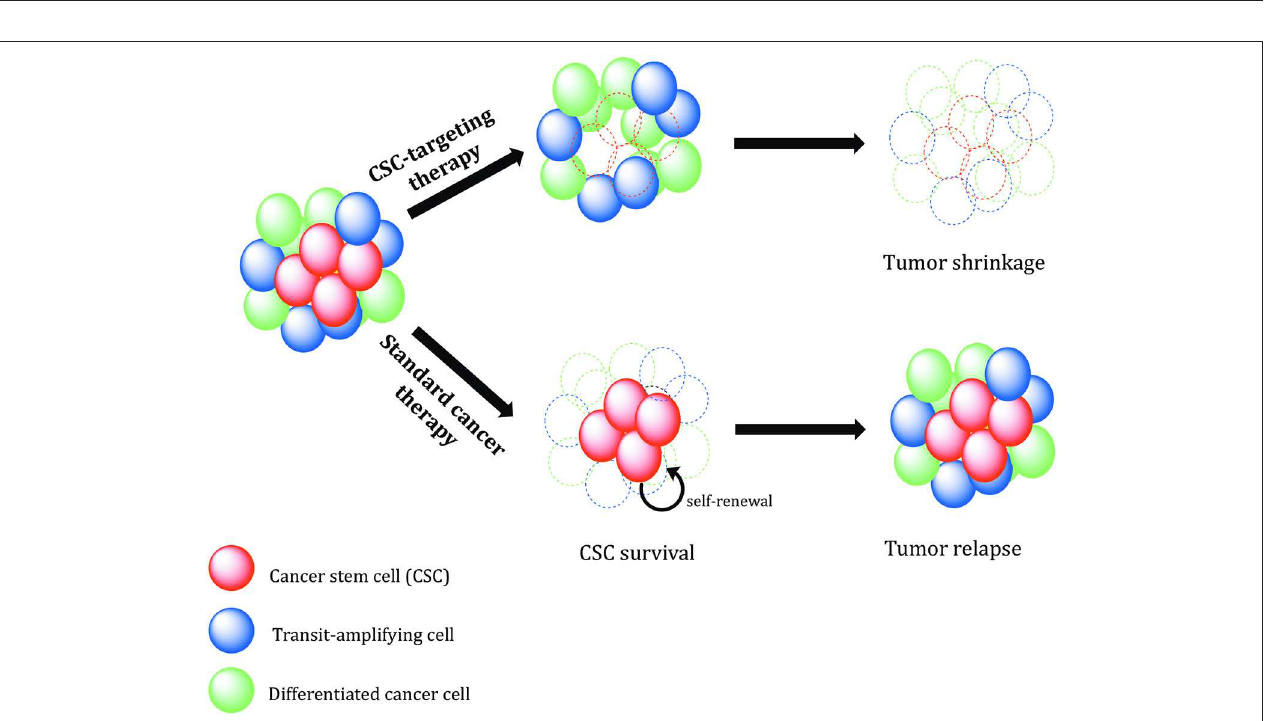
FIGURE 7 | Therapeutic relevance of cancer stem cells. Conventional cancer therapies mostly kill the tumor bulk population, while therapy-resistant cancer stem cells (CSCs) survive and continue to proliferate, leading to tumor recurrence. CSC-specific therapies need to be designed in order to precisely eradicate CSCs. Without self-renewing CSCs to drive tumor progression, the tumor shrinks, and regresses.